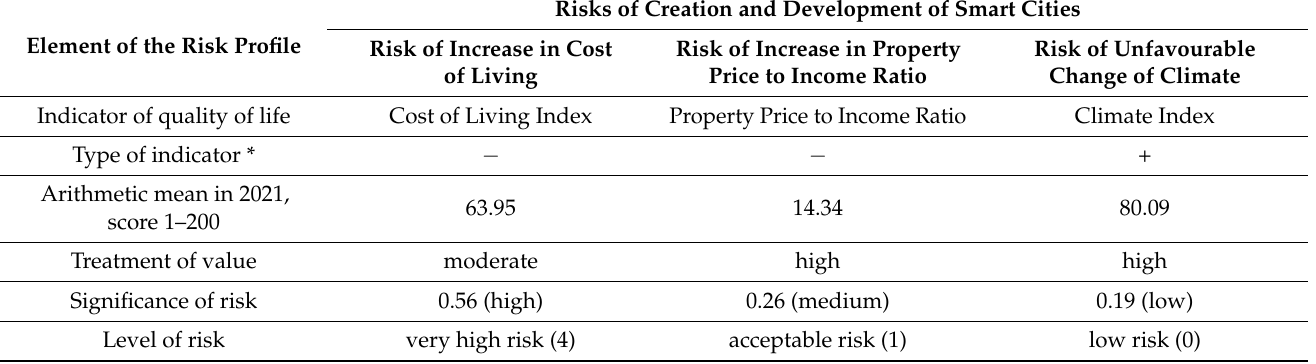
Table 3. The risk profile of smart cities in